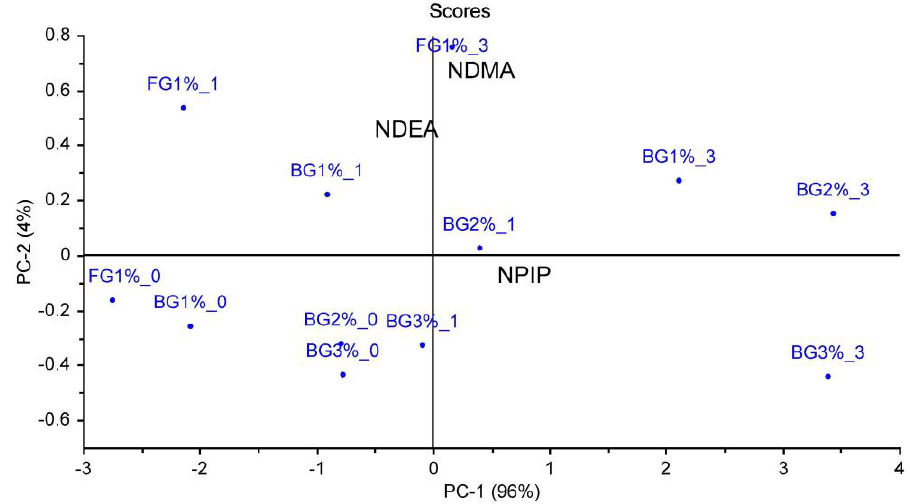
Figure 4. Cluster analysis of heatmap showing the relationship between sensory characteristics and garlic treatments (The X and Y axes represent the sensory characteristics and garlic treatments, re- spectively. (The intensity of the yellow and blue color represents from higher to lower correlation levels; GA: general acceptability).